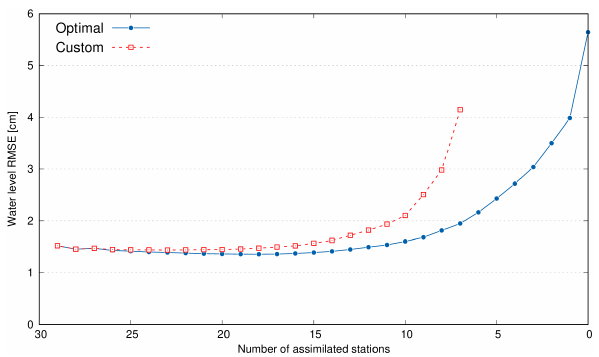
Figure 8. Same as Fig. 6 but for the optimal and the custom network experiment using nudging data